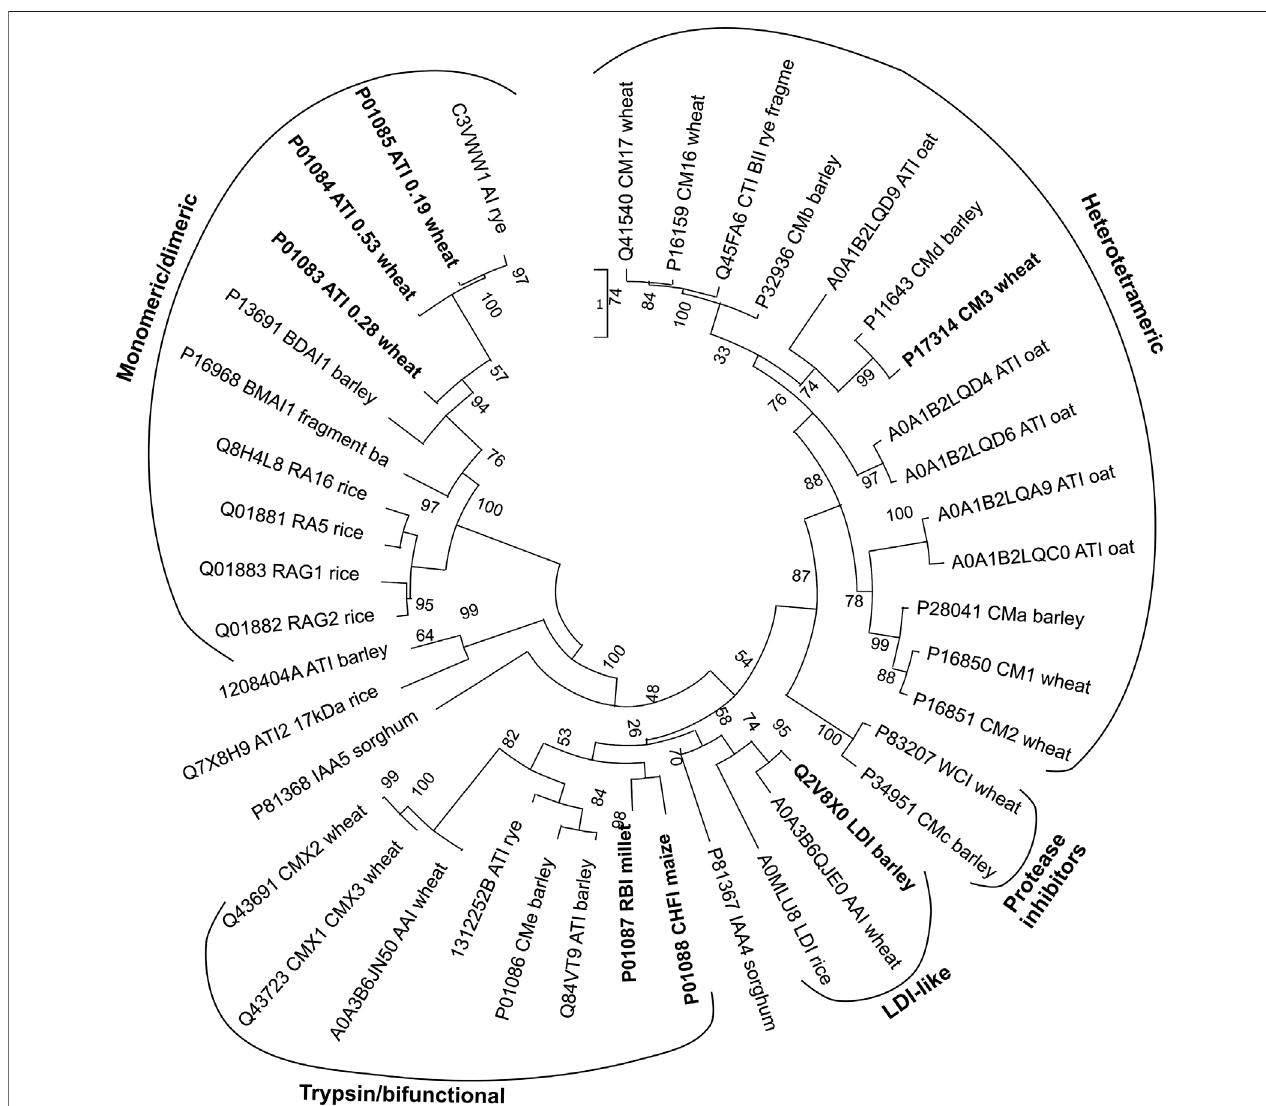
FIGURE1| PhylogeneticanalysisofcharacterizedCTIsandhomologuesfromotherplants.Thewell-characterizedproteinsincludedin Table1 areshowninbold. Namesand origin of the proteins are indicated. The sequences were retrieved from UniProt database (1 February 2022). Software used: Promals3D (Pei et al., 2008) for structure-guided multiple alignment and MEGA 11 (Kumar et al., 2018) for Maximum likelihood for phylogeny analysis. Bootstrap values for 1,000 replicates are shown.